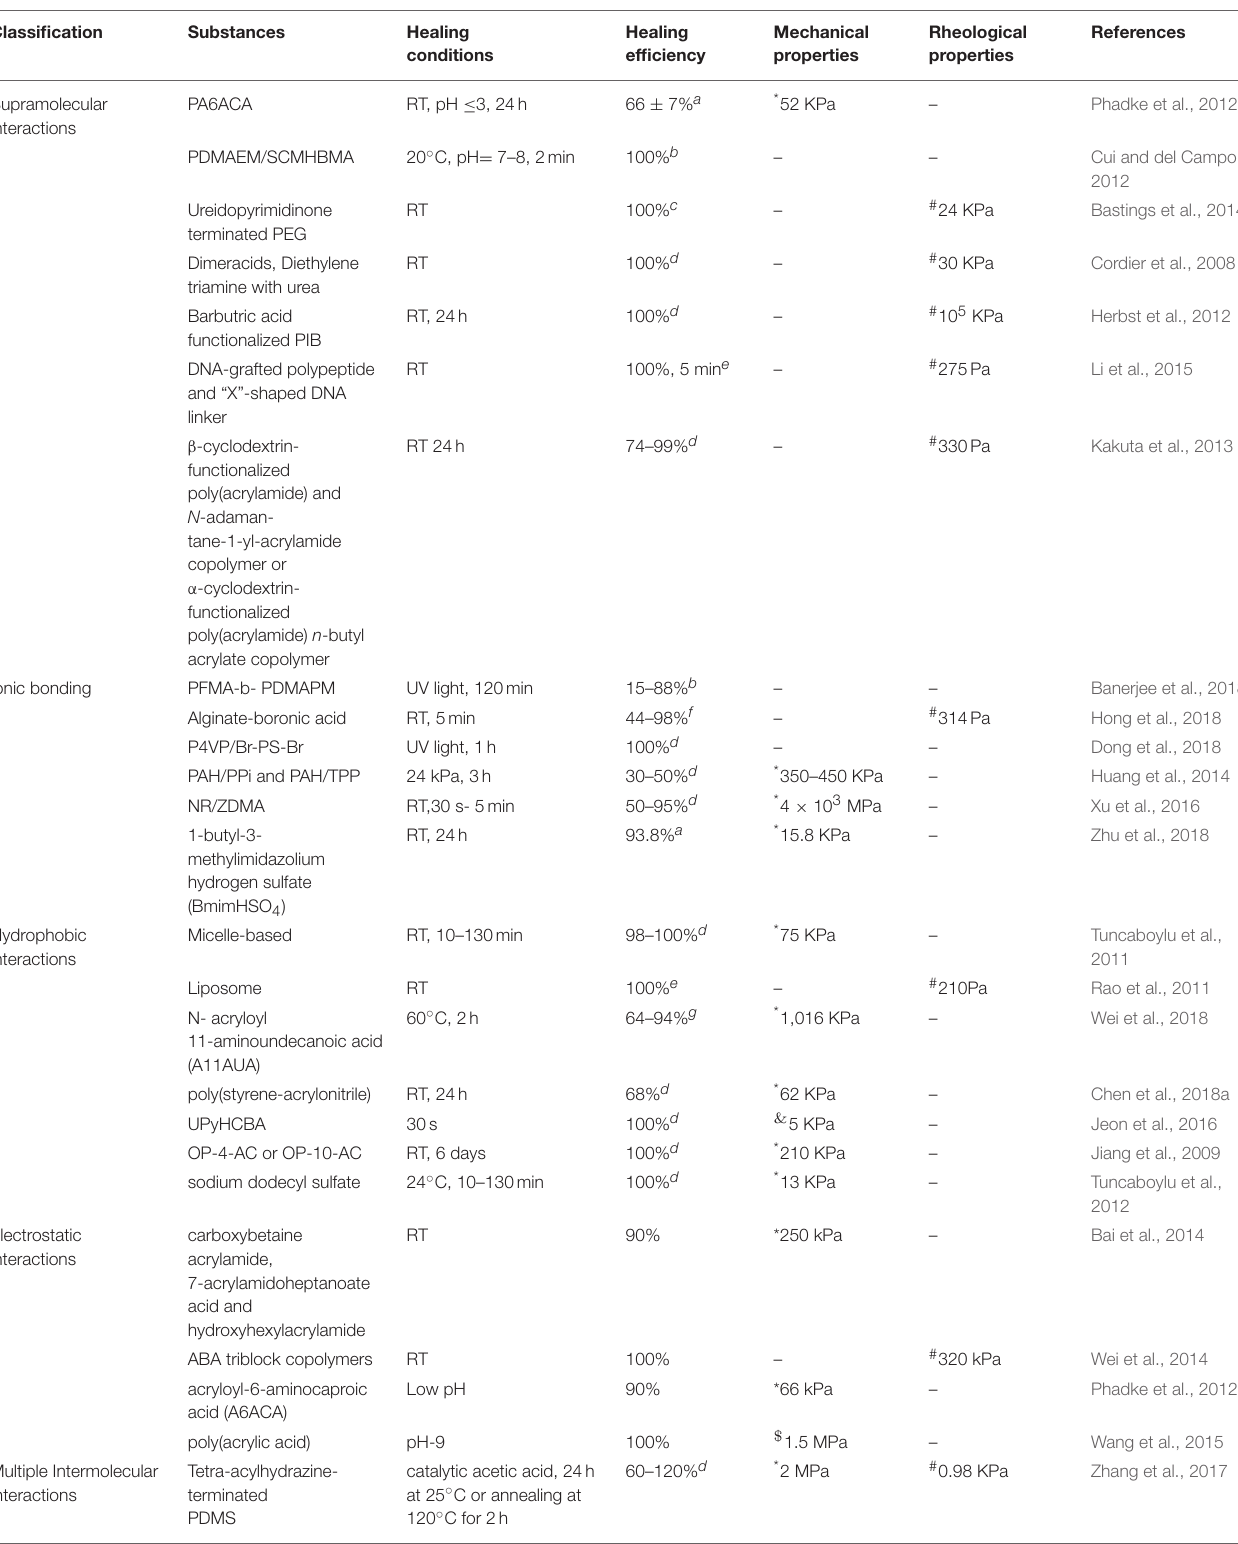
TABLE 1 | Summary of physical interactions based soft self-healing